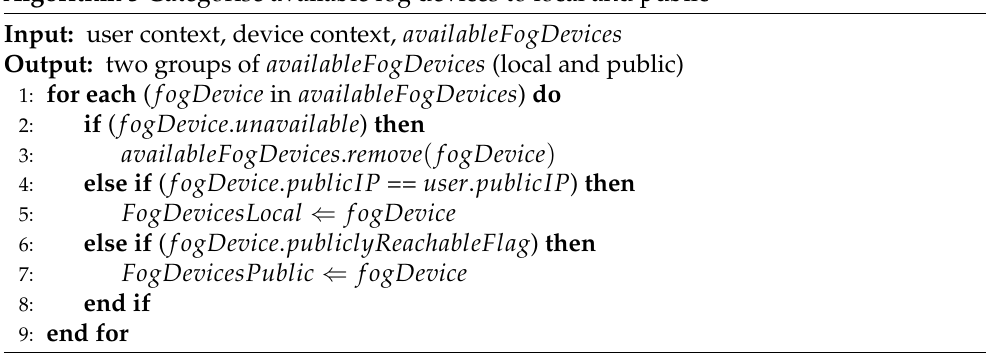
Algorithm 3 Categorise available fog devices to local and